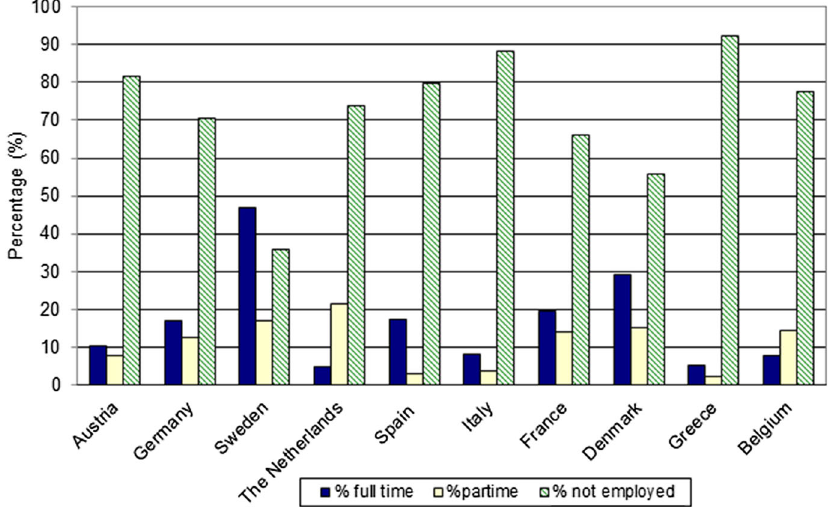
Fig. 2 Current job situation for women 50–65 who have grandchildren. Source : SHARE